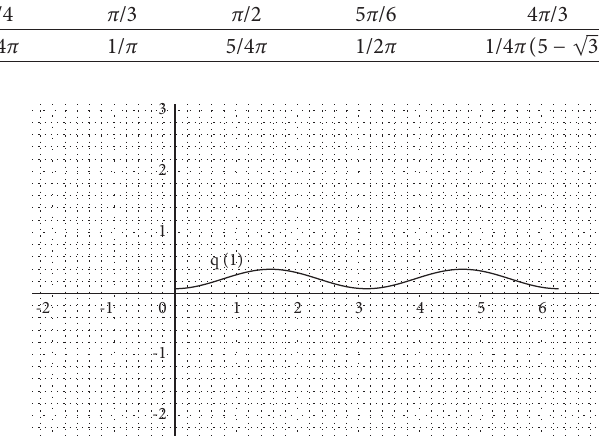
Figure 1: Potential near the edge for l � 0,